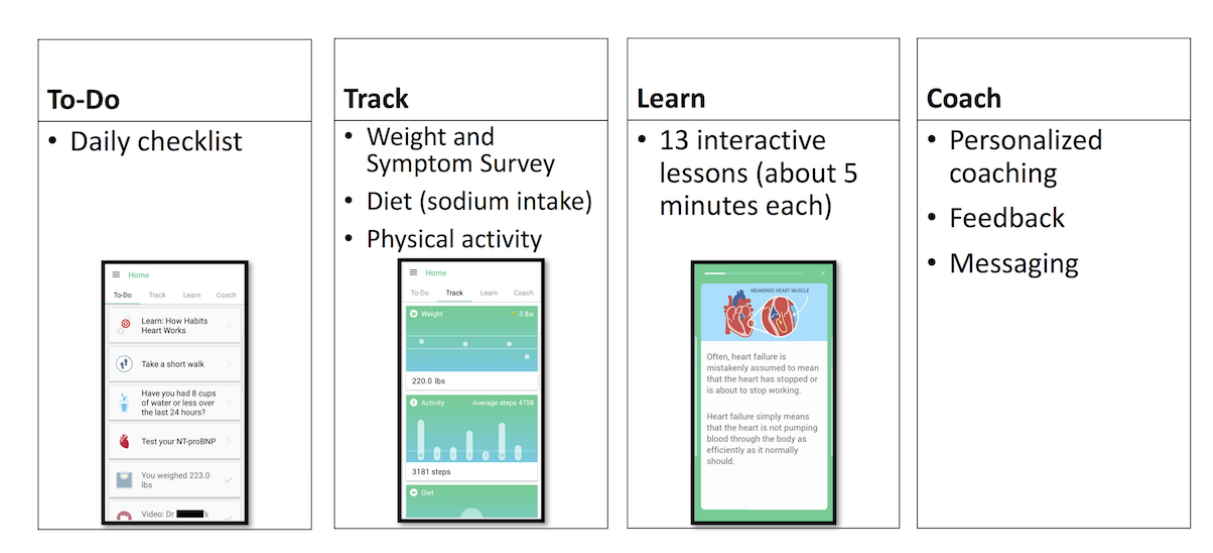
Figure 2. Layout of the Habits Heart App: To-Do List, Track, Learn,